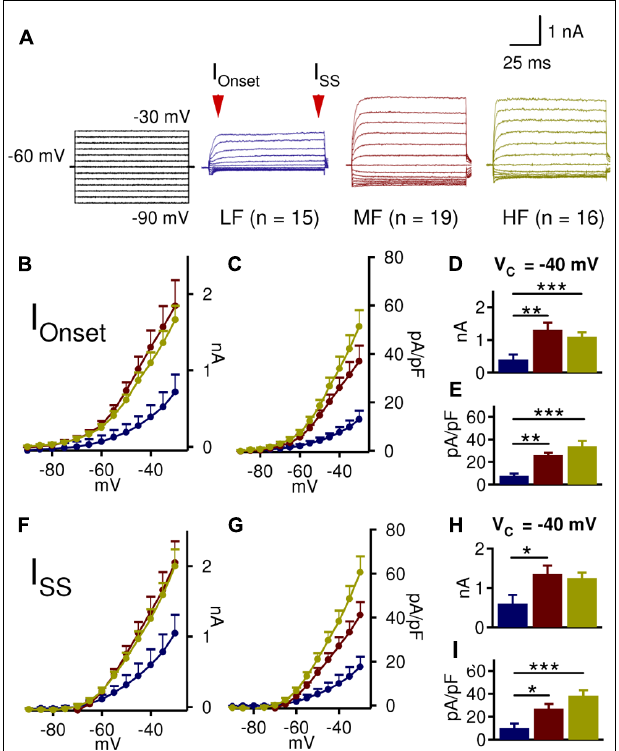
FIGURE 2 | MF and HF NL neurons have larger low threshold voltage-gated K + (LTK) currents than LF neurons. (A) Sample protocol (V hold = − 60 mV;V Command = − 90 to − 30 mV, 100 ms duration), and representative LTK current recordings from LF (blue, n = 15), MF (red, n = 19), and HF (yellow, n = 16) NL neurons. (B,C) Onset current (I Onset ) amplitude and current density in MF and HF neurons are higher than